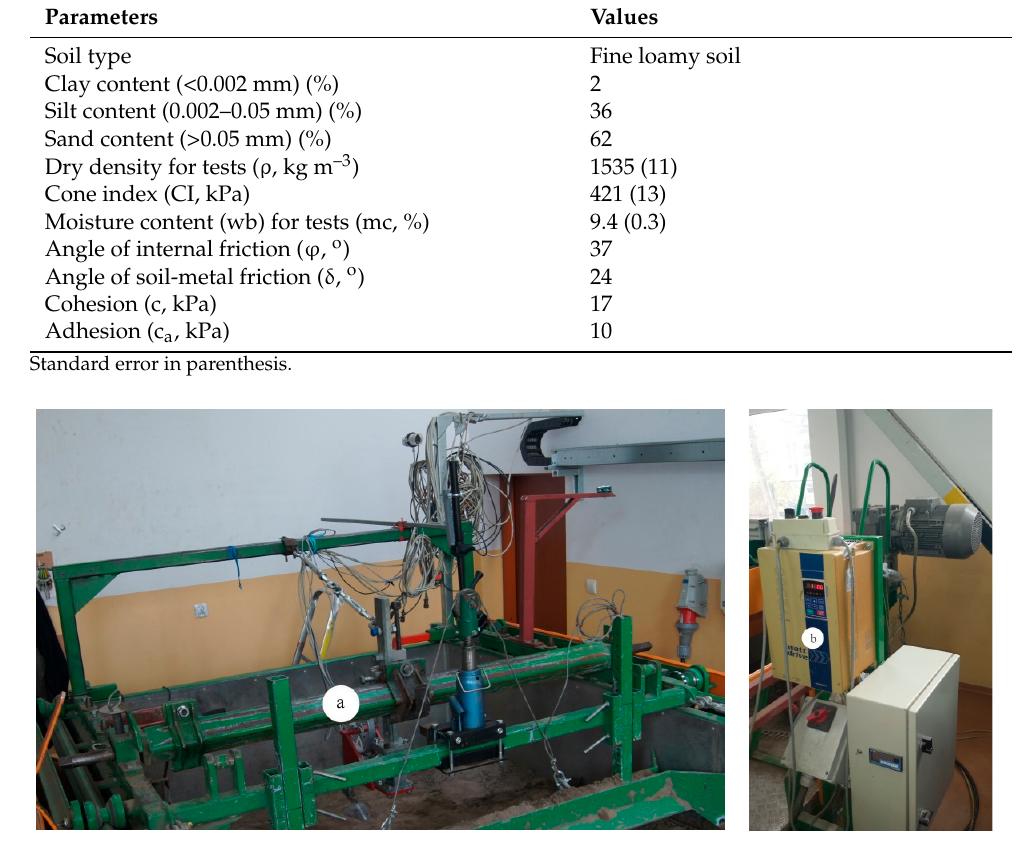
Figure 2. Tool carriage (a), drive and control system